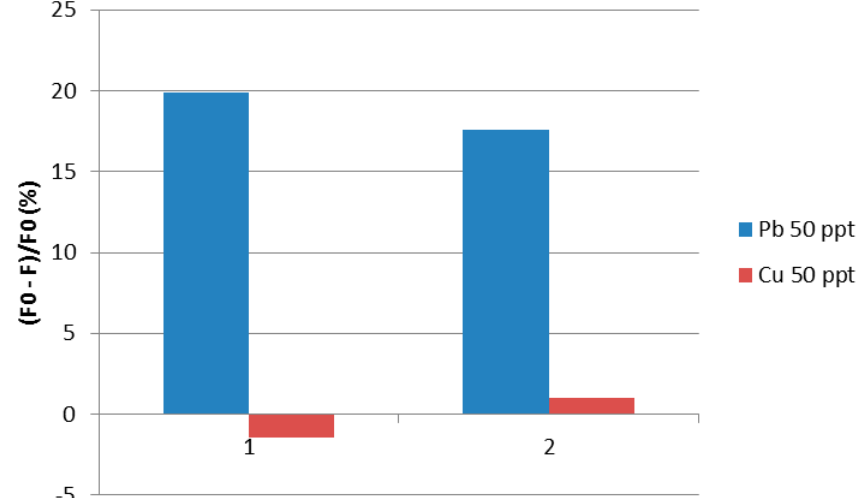
Figure 4. Relative fluorescence signal response for duplicate samples of 50 ppt Pb 2+ (blue) and Cu 2+ (red), respectively. Benzo-18-Crown-6-ether was used as ionophore for both ions.